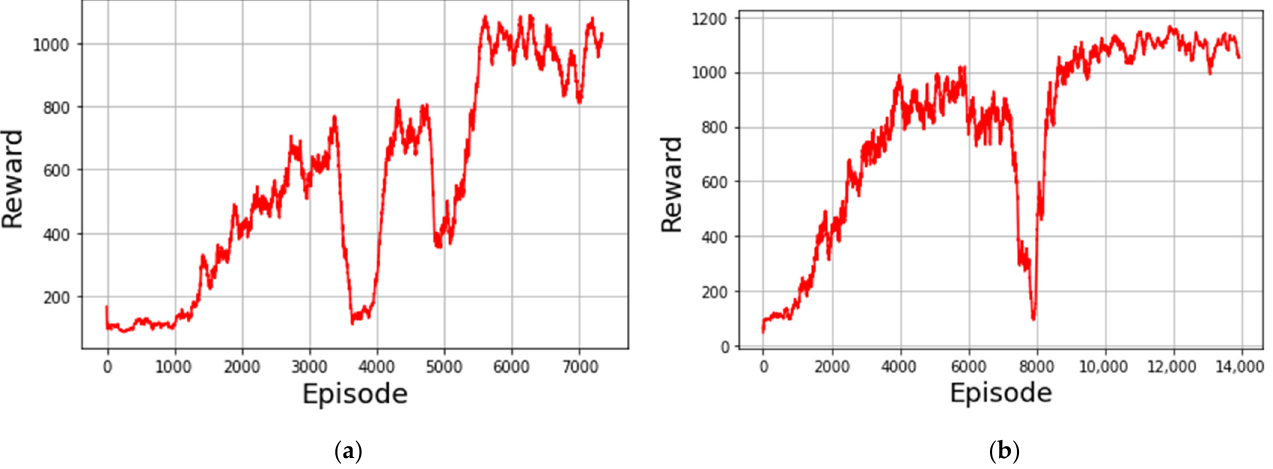
Figure 8. Learning curve in training using the sample image processing technique. ( a ) Grayscale operation. ( b ) Binarization operation.